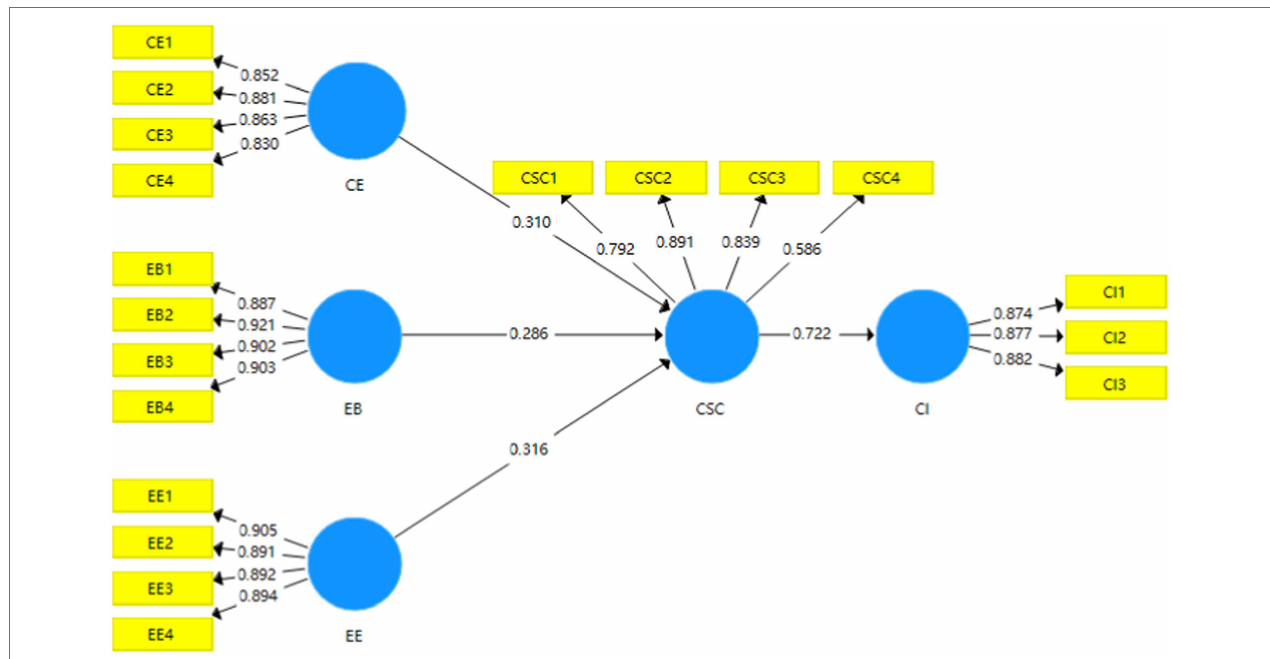
FIGURE 3 | The cognitive path coefficients. CE, Cognitive Empathy; EB, Emotional Bias; EE, Emotional Empathy; CSC, Cultural Symbol Cognition; CI, Cultural